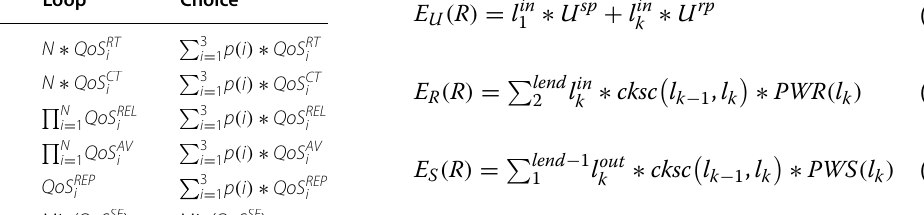
Table 1 QoS composition methods for three structures